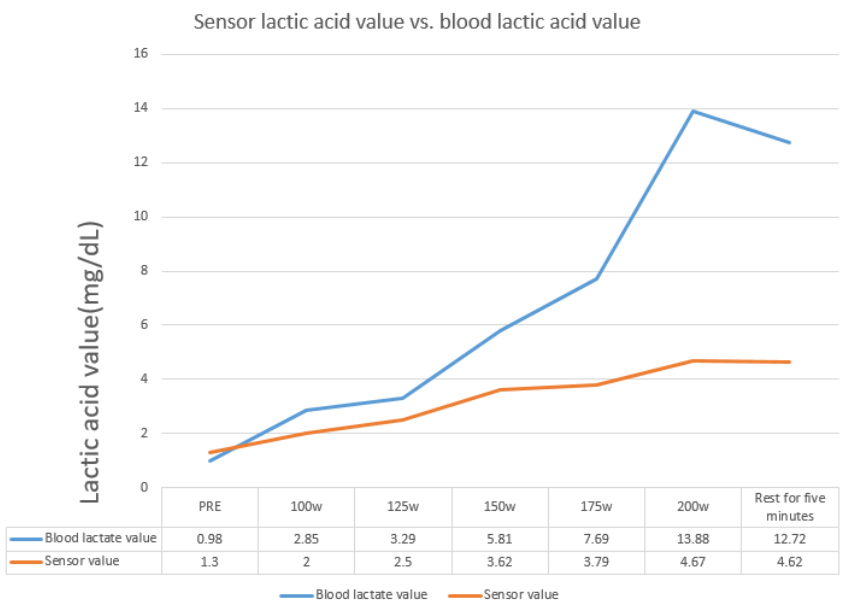
Figure 22. Human experiment data compared to blood lactate levels.